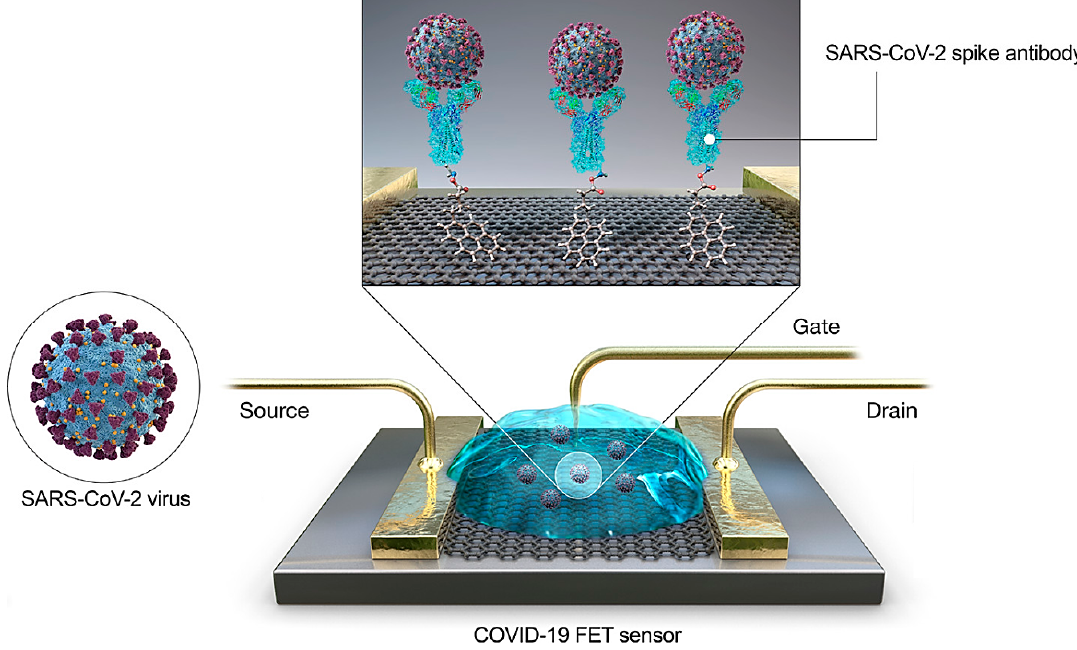
Figure 4. Field-effect transistor (FET) sensor and its related operational process for the diagnosis of COVID-19. Reproduced (adapted) with permission from [71]. Copyright © 2020 , American Chemical Society.